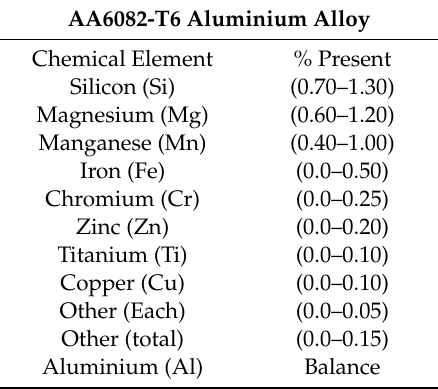
Table 1. Element composition of the AA6082-T6 aluminium alloy (wt %). Data from [29].